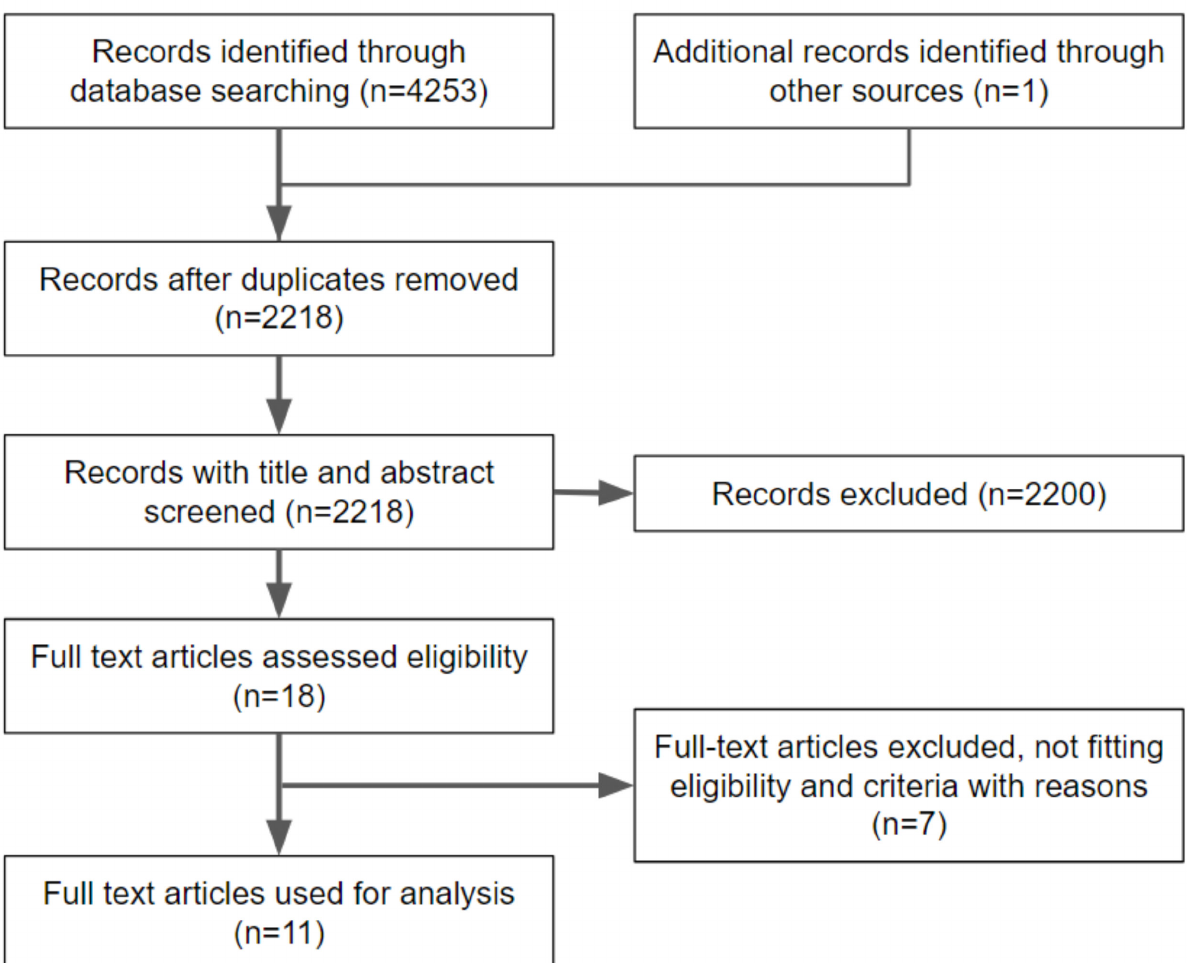
Figure 1. Flow diagram of study selection